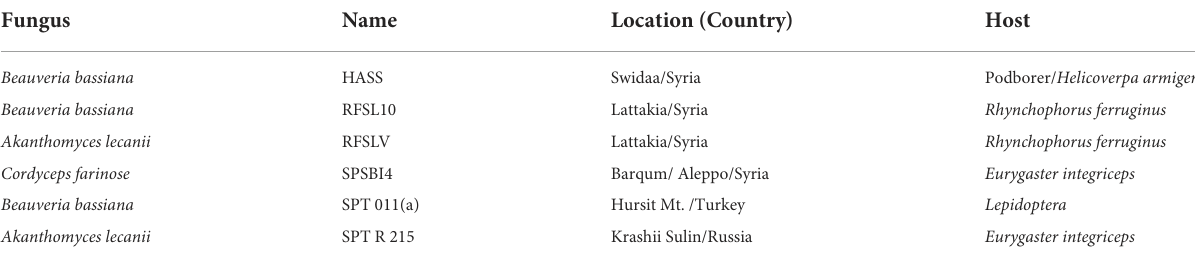
TABLE 1 Six isolates of entomopathogenic fungi used in the laboratory bioassay on D. opuntiae nymphs and females.